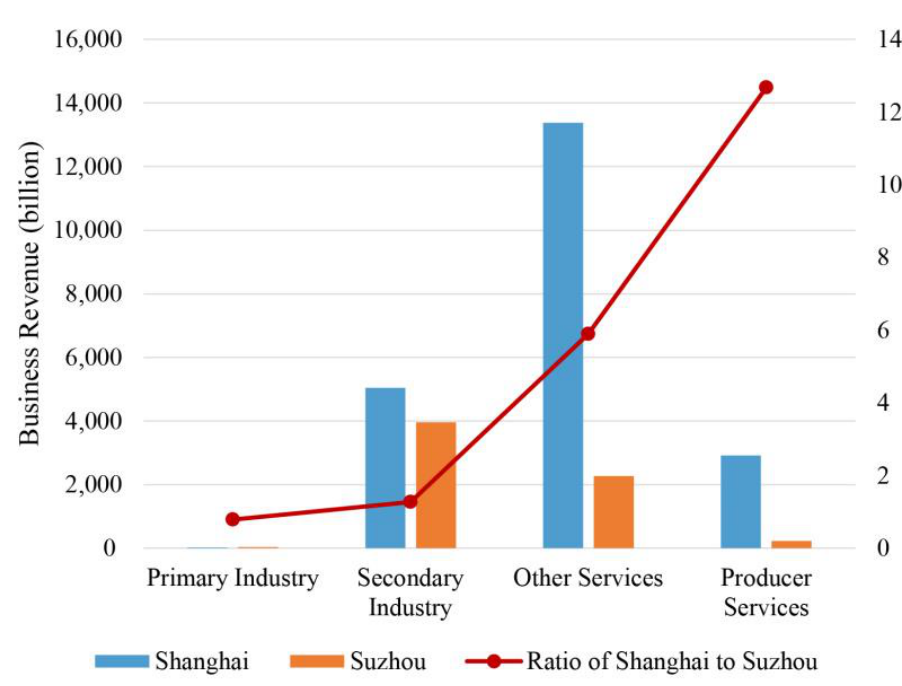
Figure 2. Above-scale business revenue of Shanghai and Suzhou by industry type. The distance between the downtown areas of Suzhou and Shanghai is over 100 km, which would take more than one hour and a half by train before the advent of HSR. Since the Shanghai–Nanjing Intercity Railway and Beijing–Shanghai High-speed Railway were completed in 2010, the traveling time has been reduced to 30 min and railway has become the primary commuting mode for intercity commuters between the two cities. In 2020, the Southern Riverside Intercity Railway went into operation. Although it plays only a limited role in intercity commuting currently, it may manifest more potential in the future. Commuters from Suzhou can get aboard at multiple railway stations in Suzhou and get off at Hongqiao Railway Station or Shanghai Railway Station in downtown Shanghai. Moreover, Shanghai’s metro line 11 links Suzhou and Shanghai, meaning residents in the areas neighboring Shanghai can easily reach downtown Shanghai by subway.